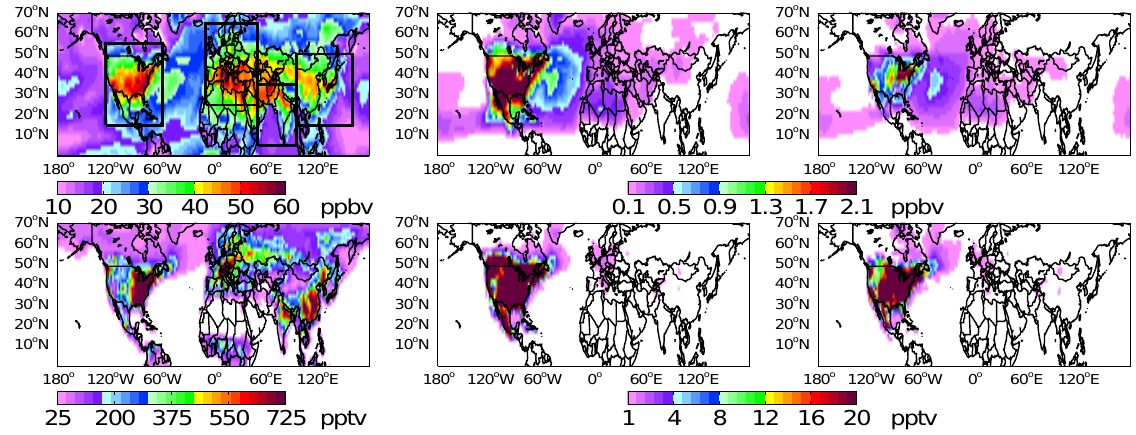
Fig. 1. August 2001 surface mixing ratio of O 3 (top) and PAN (bottom) in the MOZART-2 base (SR1) simulation (left); 1 O 3 ANTH (top) and 1 PAN ANTH (bottom) diagnosed as the difference between the SR1 and SR6NA simulations (middle); and 1 O 3 ISOP (top) and 1 PAN ISOP (bottom) diagnosed as the difference between the ISOPNA and SR1 simulations (right). Regions outlined in black, from left to right are: North America (NA), Europe and North Africa (EU), South Asia (SA), and East Asia (EA), as in TFHTAP (2007). Note the different scales on each color bar. Areas below the minimum values are shown in